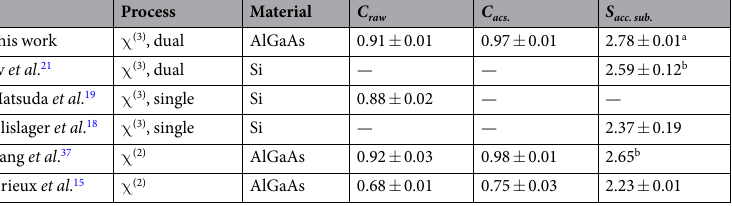
Table 2. Comparison of concurrence and S parameter of our source with other sources of polarization- entangled photons. a Estimated from reconstructed density matrices as described previously. b Estimated from reported visibility of two-photon interference